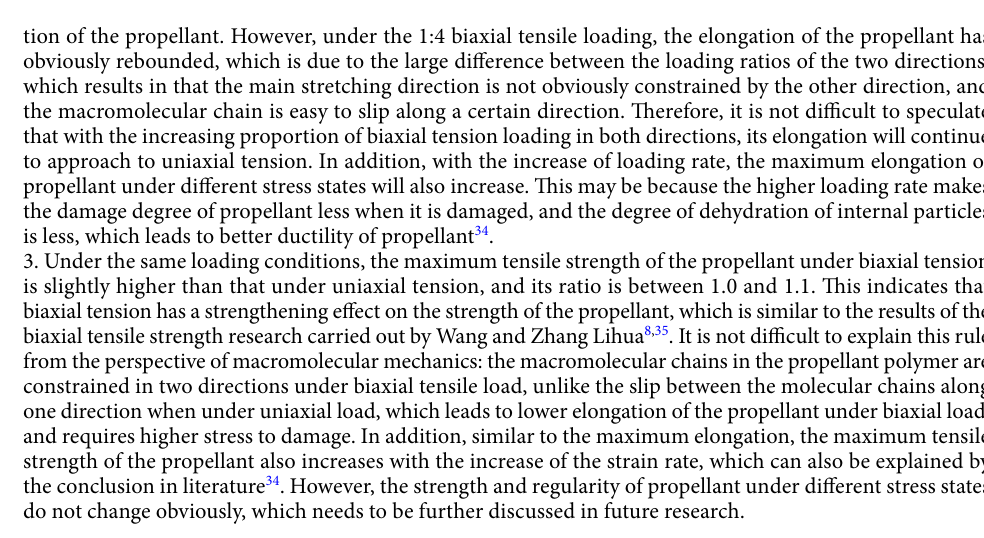
Figure 10. Tensile stress–strain curves of HTPB propellant at different strain rates and different stress states at room